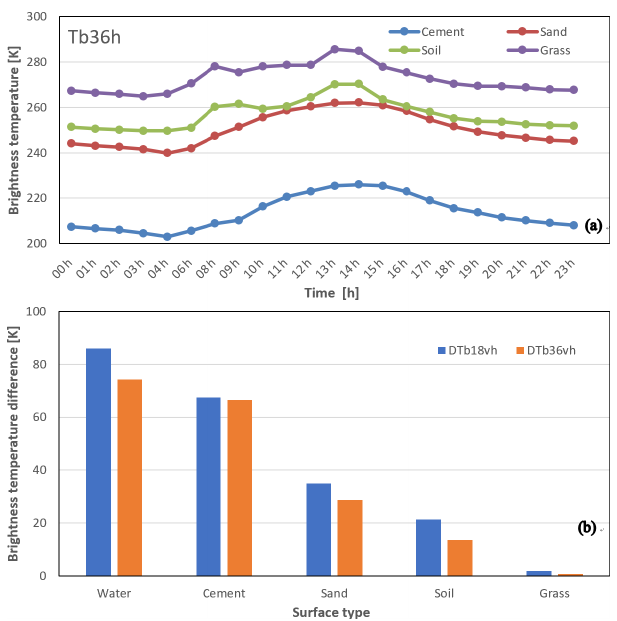
Figure 5. Variations in the observed T b (a) and T b polarization dif- ferences (b) over different surfaces in October